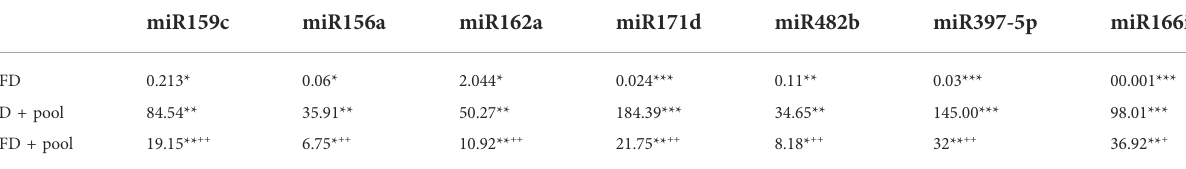
TABLE 5 The mol -miRs relative level in mouse livers, quanti fi ed by qPCR, and normalized with the housekeeping gene 5S